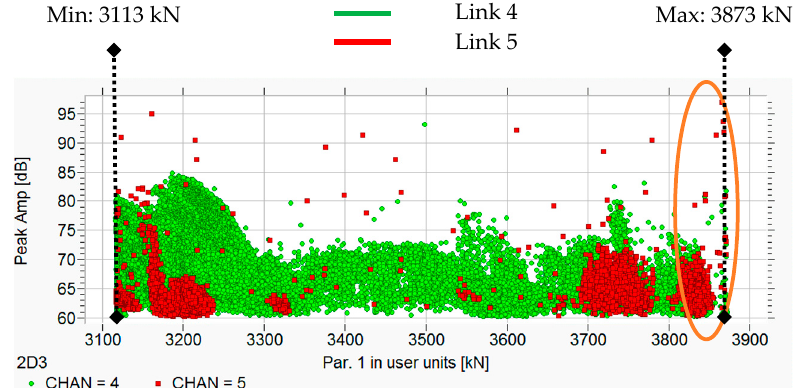
Figure 8. Peak amplitude (dB) vs. load (kN). Details of the minimum–maximum loading, and the 3820–3873 kN range is highlighted.